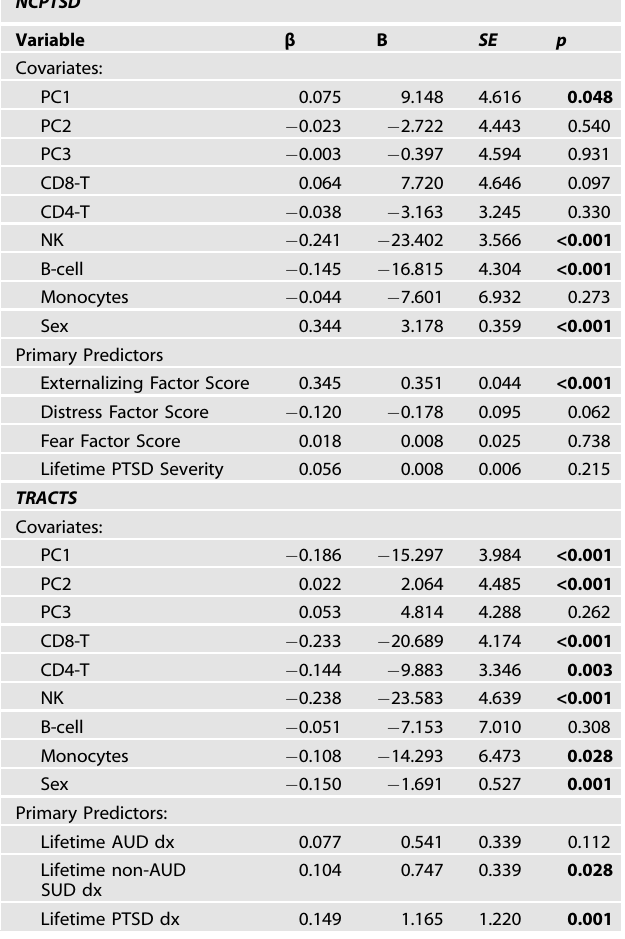
Table 2. Psychopathology as a predictor of GrimAge residuals in both